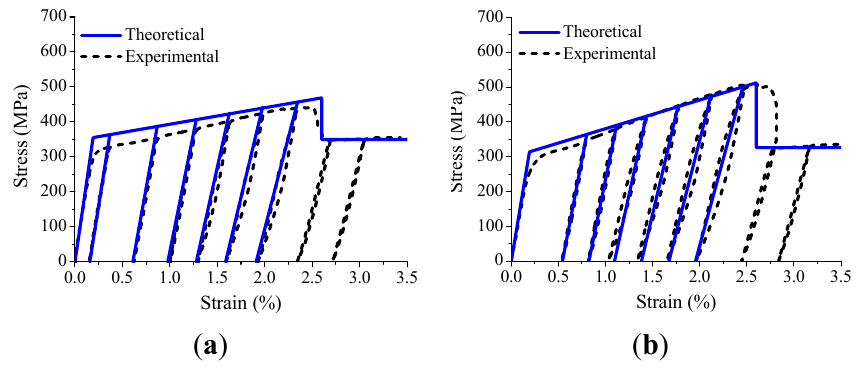
Figure 15. Stress–strain curves of the calculated and test results for BSP under cyclic tensile loading: ( a ) BSP2; ( b ) BSP4; ( c ) BSP6; and ( d )